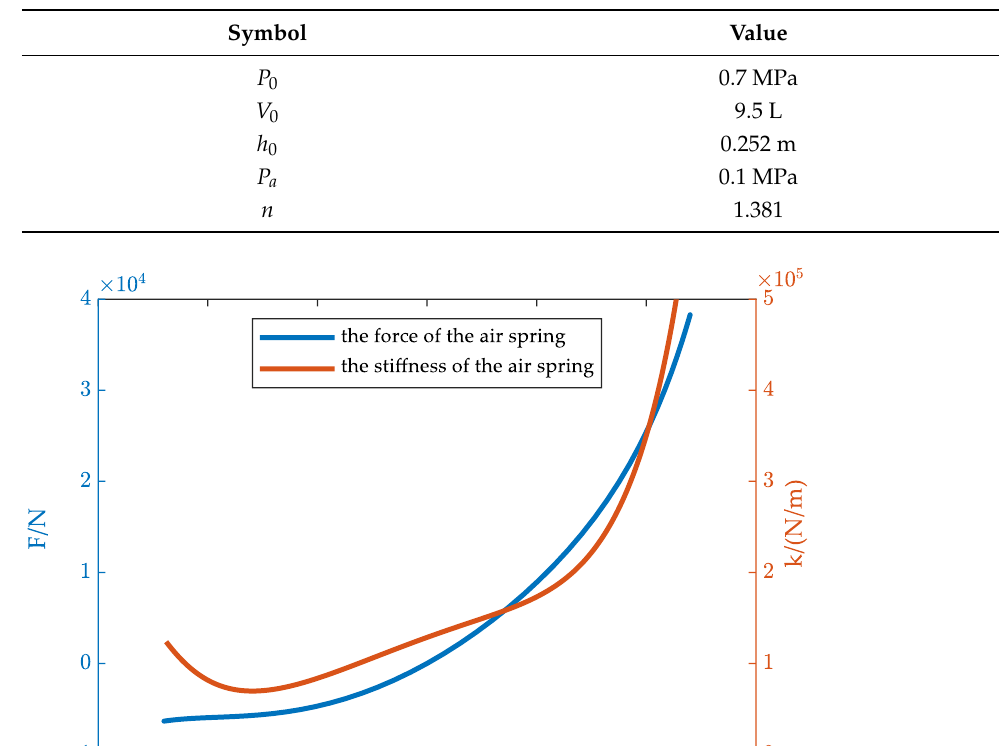
Table 2. Parameter values of the air spring.